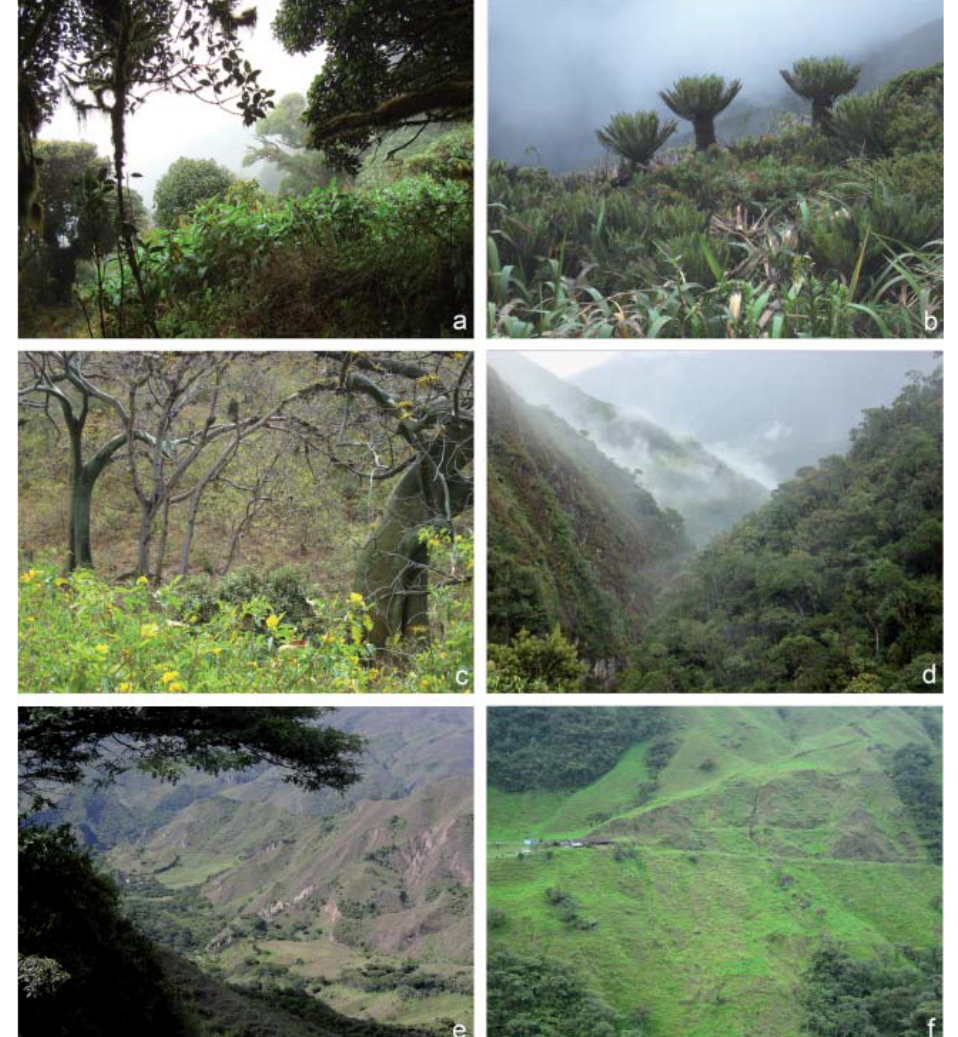
Figure 12: While the upper four pictures introduce natural or nature-near vegetation formations of the area shown in Fig. 9, the lower two show typical landscapes changed by human impact. (a) Cajanuma (elfin forest; 3,160 m a.s.l.): trees of Hedyosmum racemosum and Weinmannia rollottii with herbaceous Rumex tolimensis; (b) Cerro Toledo (shrub páramo; 3,240 m a.s.l.): ferns of Blechnum loxense , bamboos of Neurolepis laegardii and Chusquea neurophylla, shrubby Ericaceae of Gaultheria rigida and Macleania rupestris ; (c) Laipuna (dry forest; 630 m a.s.l.): Tecoma stans in the foreground, evergreen Capparis scabrida in the center, Ceiba trichistandra with green bark, and Cochlospermum vitifoli- um with grey bark; (d) RBSF (mountain rainforest; 1,850 m a.s.l.); (e) semiarid inner-Andean valley around Masana- maca (extensive pasture land and irrigated permacultures in the valley ground; 1,620 m a.s.l. ); (f) perhumid eastern escarpment of the Cordillera Real around Sabanilla (extensive pastures; 1,680 m a.s.l.) (photos: M.